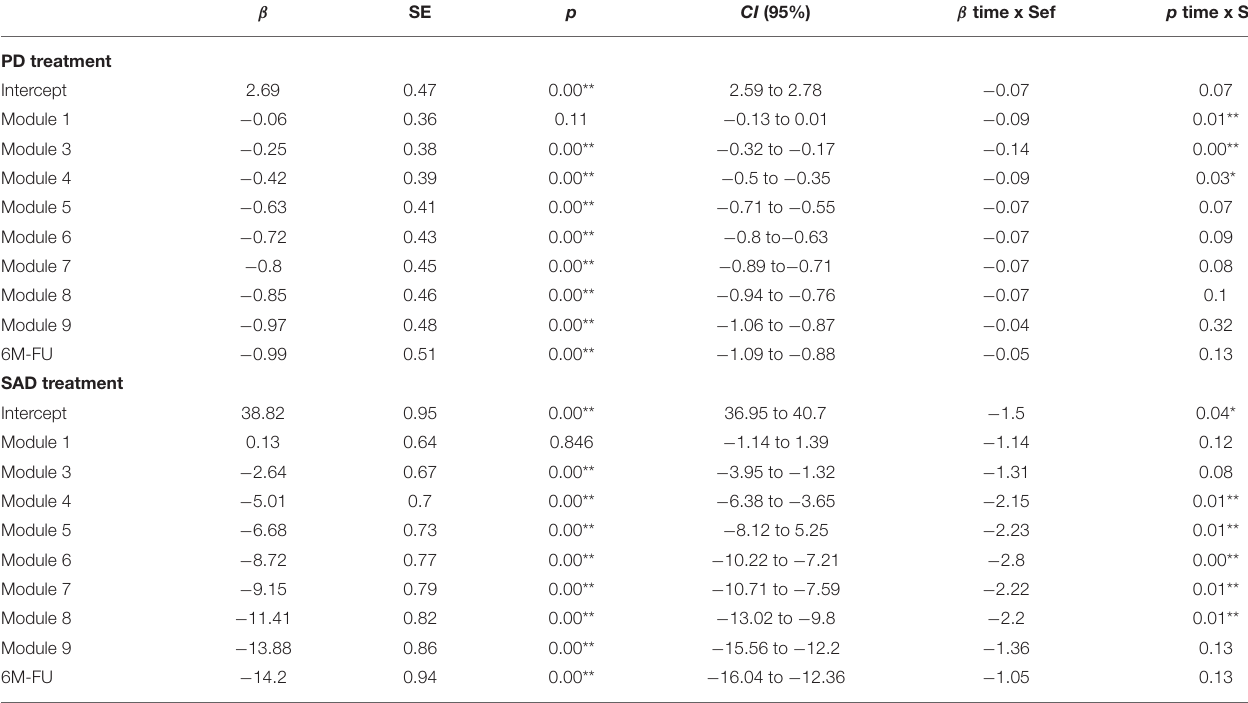
TABLE 6 | Results of MLM analysis of treatment self-efficacy and symptomatic reduction. β SE p CI (95%) β time x Sef p time x